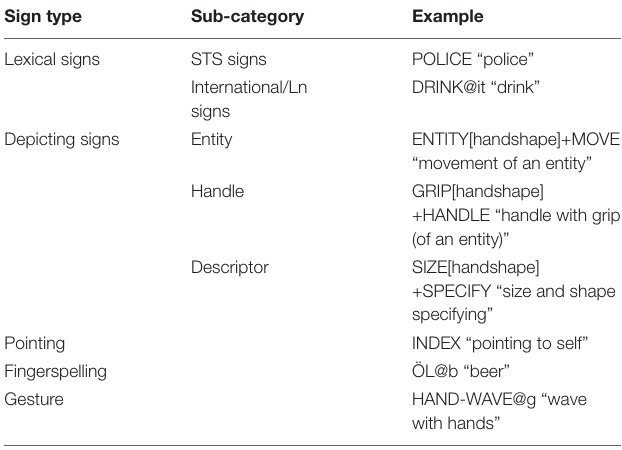
TABLE 1 | Coding of sign type